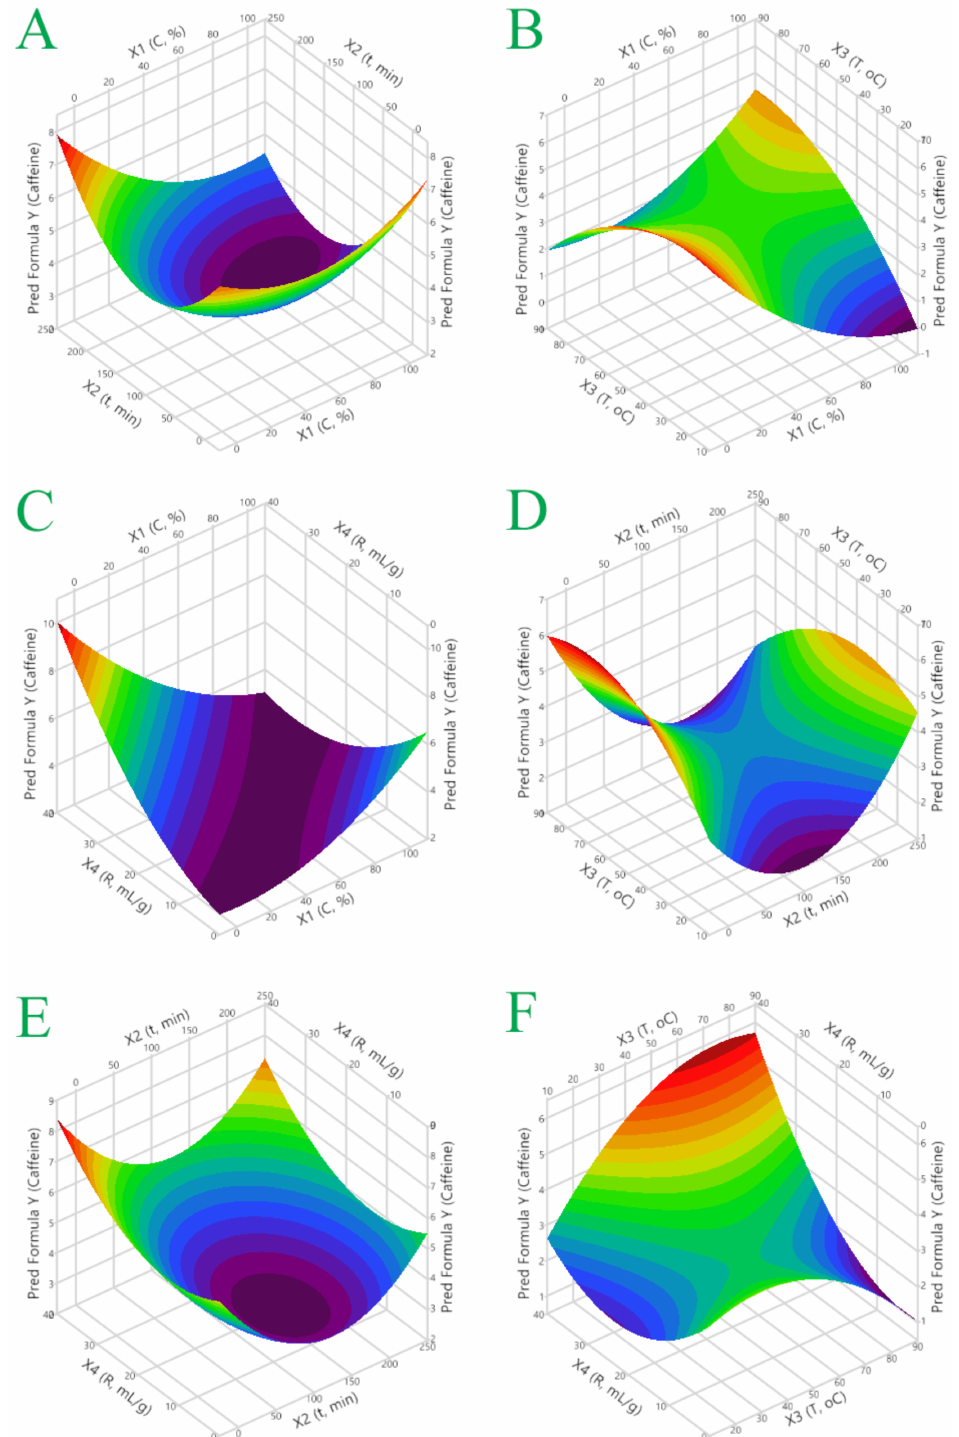
Figure 1. 3D graphs depicting the effect of the process variables considered on the response (caffeine, mg/g), for the optimization of spent coffee grounds extraction performed with hydroethanolic solutions. Plot ( A ), covariation of X 1 ( C , %) and X 2 ( t , min); plot ( B ), covariation of X 1 ( C , %) and X 3 ( T , ◦ C); plot ( C ), covariation of X 1 ( C , %) and X 4 ( R , mL/g); plot ( D ), covariation of X 2 ( t , min) and X 3 ( T , ◦ C); plot ( E ), covariation of X 2 ( t , min) and X 4 ( R , mL/g); plot ( F ), covariation of X 3 ( T , ◦ C) and X 4 ( R ,